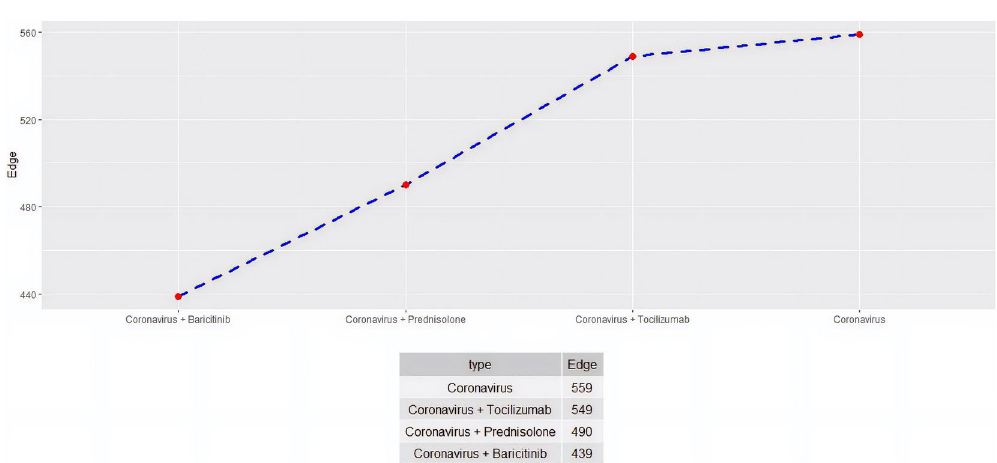
Figure 2. Network size of the human Janus Kinase/Signal Transducers and Activators of Transcription (JAK/STAT) pathway network infected with coronavirus. The system is further tested in terms of size after with glucocorticoids and least with